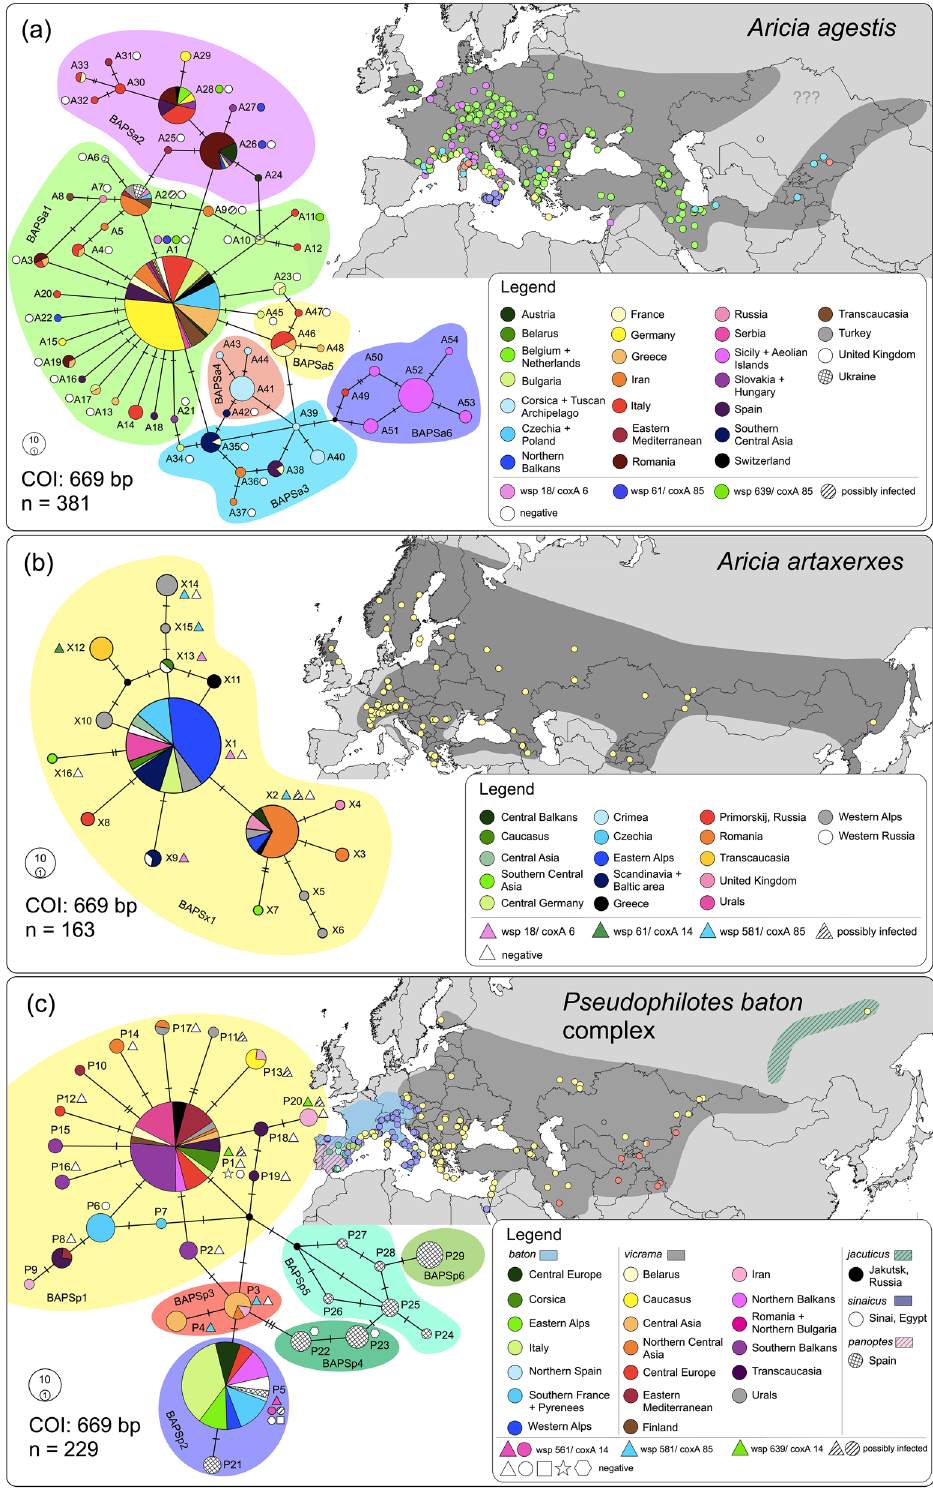
Figure 1. TCS haplotype networks of ( a ) Aricia agestis , ( b ) Aricia artaxerxes and ( c ) Pseudophilotes baton species complex, based on COI. The colours of map points correspond to BAPS clusters (coloured network background). The shades on the maps represent the distribution of each taxon. The specimens in the networks were allocated to geographical or political regions, for readers’ orientation. The haplotypes, in which some of the individuals were inspected for Wolbachia infection, are indicated, with a different mark for each bacterial strain. These marks correspond to Fig. 3; and in ( c ), circle = P. baton, triangle = P. vicrama , square = P. sinaicus , star = P. b. jacuticus , hexagon = P. panoptes. Note that COI sequences not marked with any symbol were obtained in databases and hence not tested for Wolbachia . Maps were created in QGIS v. 2.18 (http:// qgis.org) and the graphics was compiled in Graphic for Mac v. 3.1 (https ://www.graph